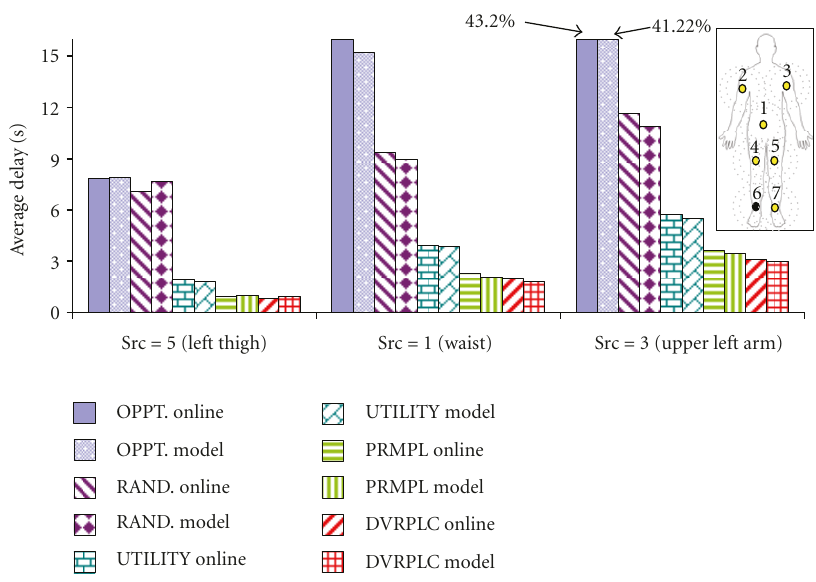
Figure 12: Delivery delay for packets from thigh, waist, and arm to right ankle (i.e., node